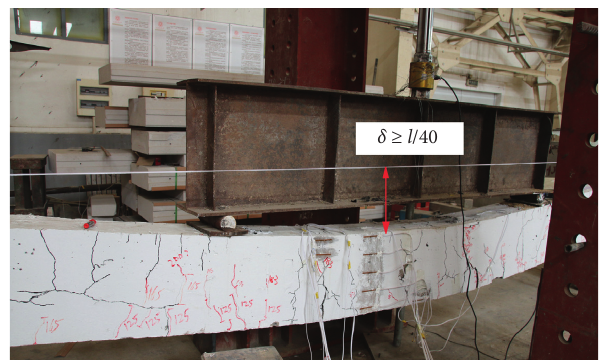
Figure 10: Deflection under static load of postfire prestressed RPC beams.